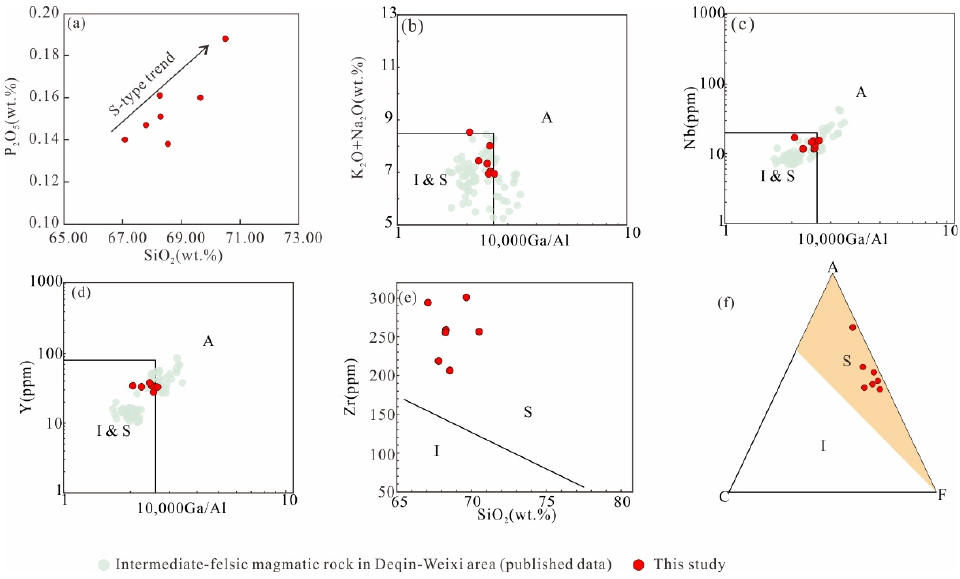
Figure 9. Petrogenetic discrimination plots for the Madeng dacite. ( a ) P 2 O 5 vs. SiO 2 ; ( b – d ) 10,000 Ga/Al vs. (K 2 O + Na 2 O), Nb and Y [51]; ( e ) SiO 2 vs. Zr; ( f ) A(Al 3 O 2 -Na 2 O-K 2 O)-C(CaO)-F(FeO T + MgO) [50]. Data source: [8,10–12,15,43].